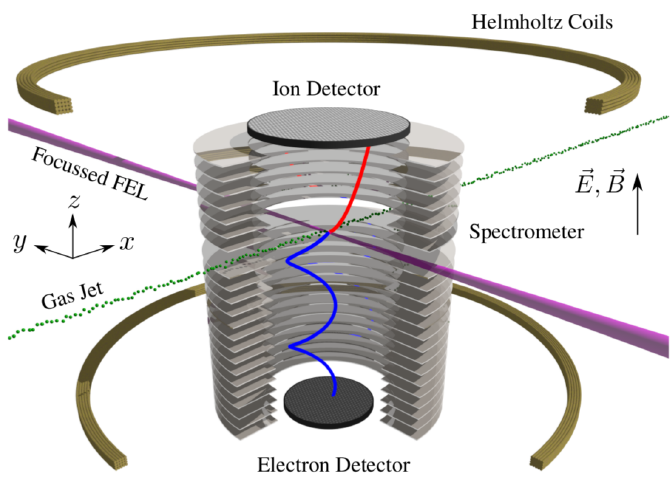
Figure 2. Schematic of the reaction microscope. Reproduced from [19], with the permission of the International Union of